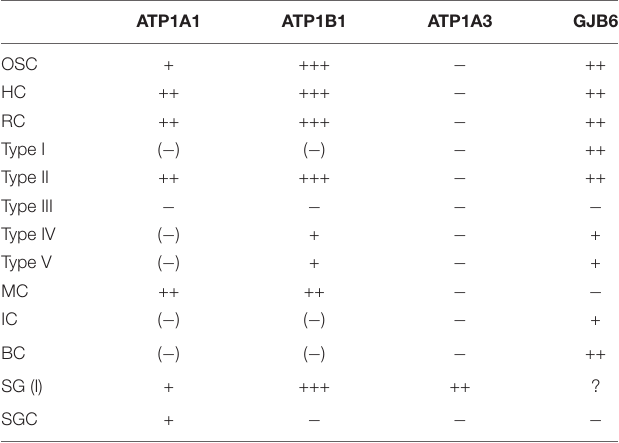
TABLE 3 | Relative expression of gene